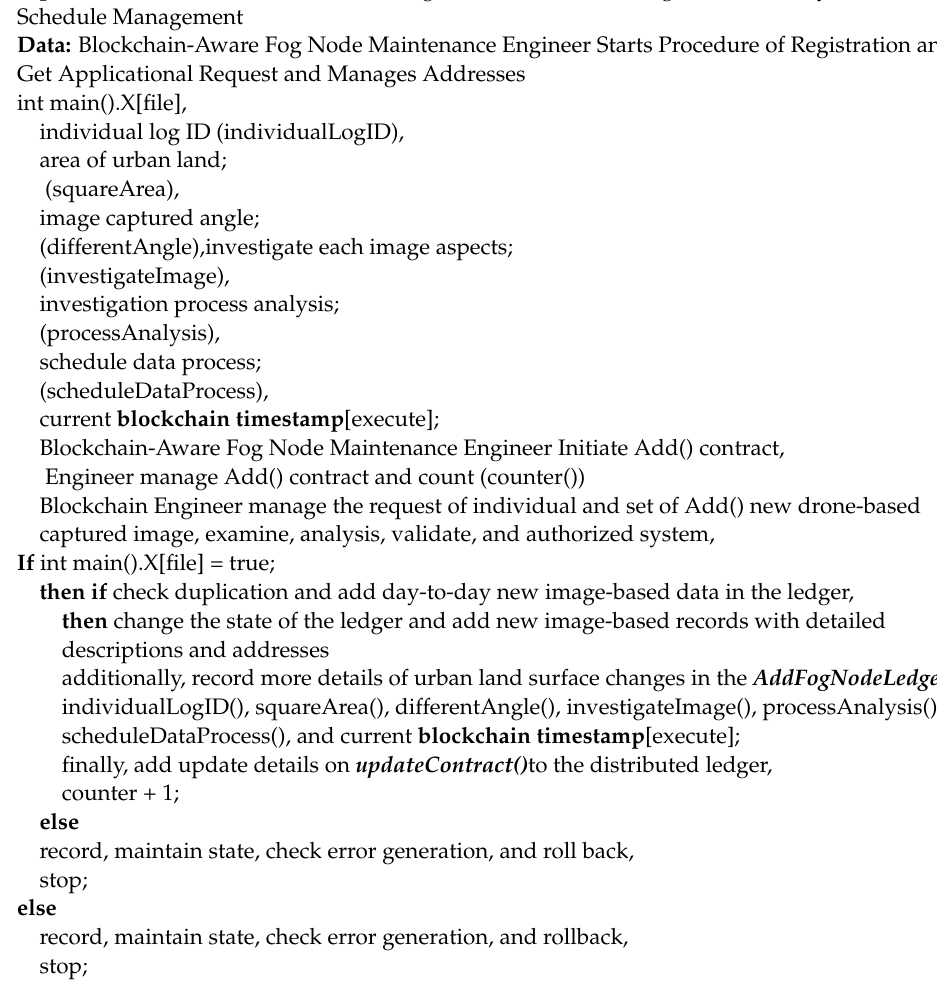
Algorithm A2. Add Drone-based Captured Image Data in the Distributed Fog Node